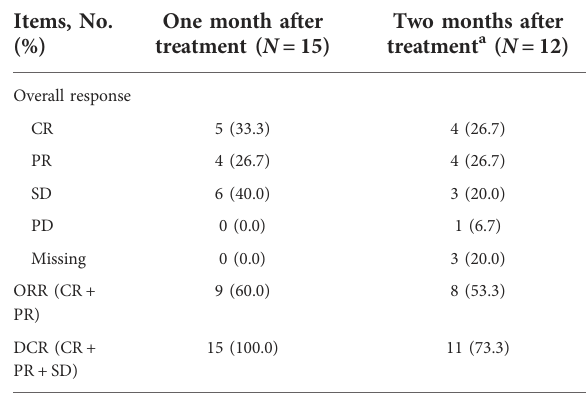
TABLE 3 Treatment